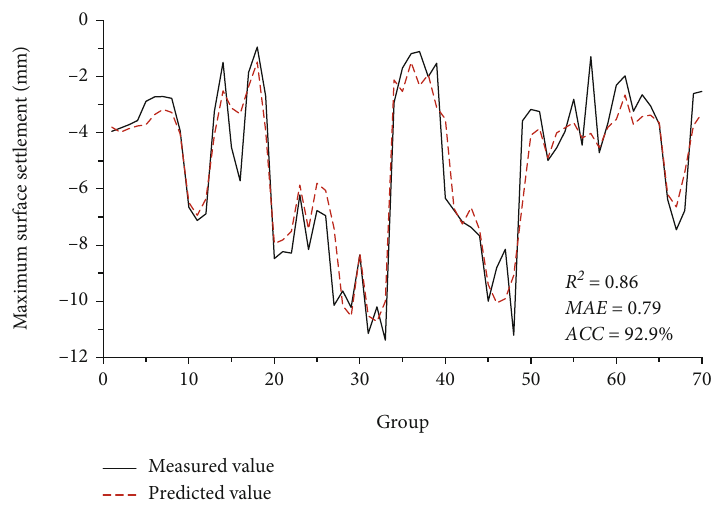
Figure 7: Prediction of optimized model with RF key parameters.